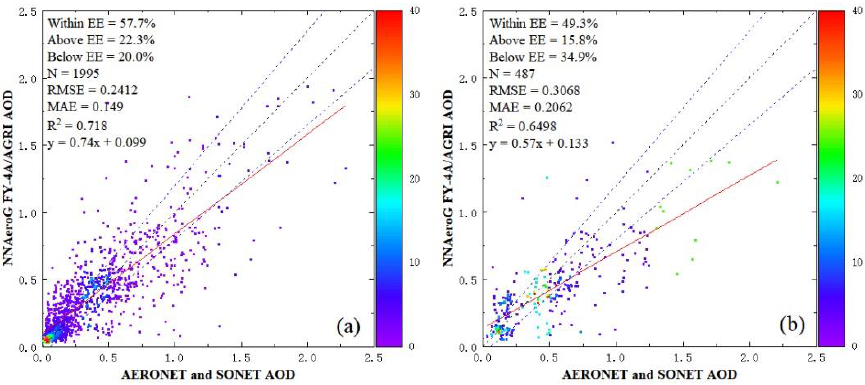
Figure 11. Scatterplots of the AOD retrieved using FY-4A/AGRI over full disk ( a ) and arid areas ( b ) versus AERONET and SONET reference data. The blue lines are the EE envelopes for AOD of ± (0.05 + 15%). The red line is the linear fitting line of AOD. The black line represents the 1:1 line.